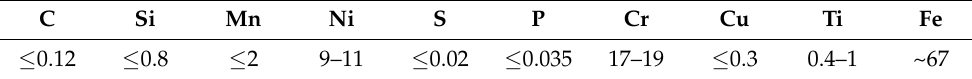
Table 1. Chemical composition (in %) of the steel of the